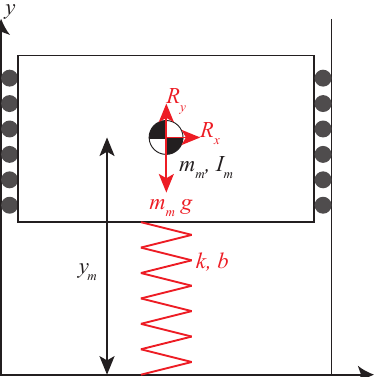
Figure 2. Basketball Robot free body